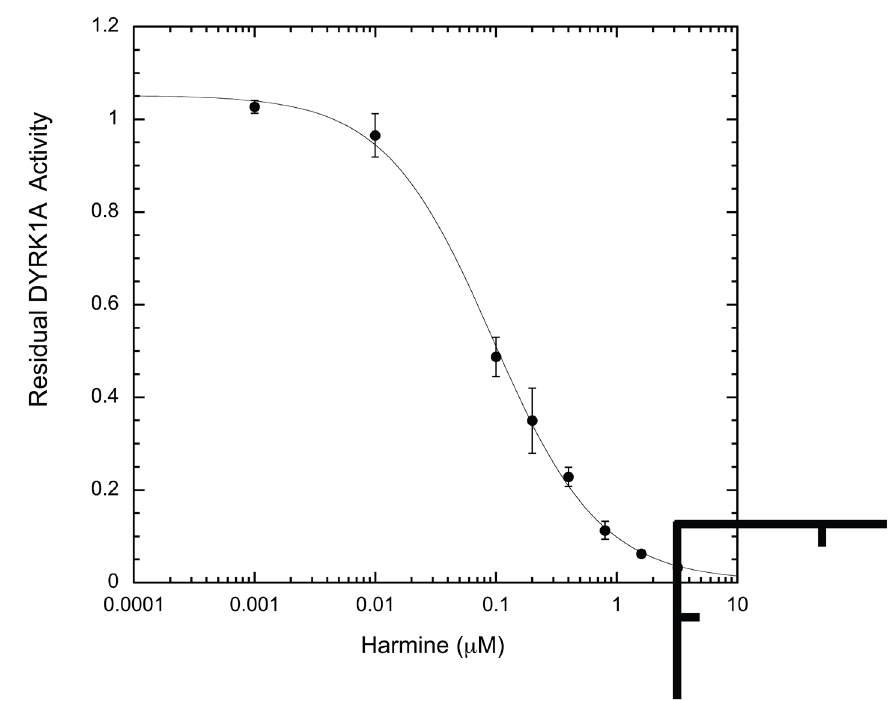
Figure 6B. Harmine inhibition profile. Harmine inhibition was conducted and analyzed exactly as described in Figure 6A for EGCG (n = 6 for each data point).